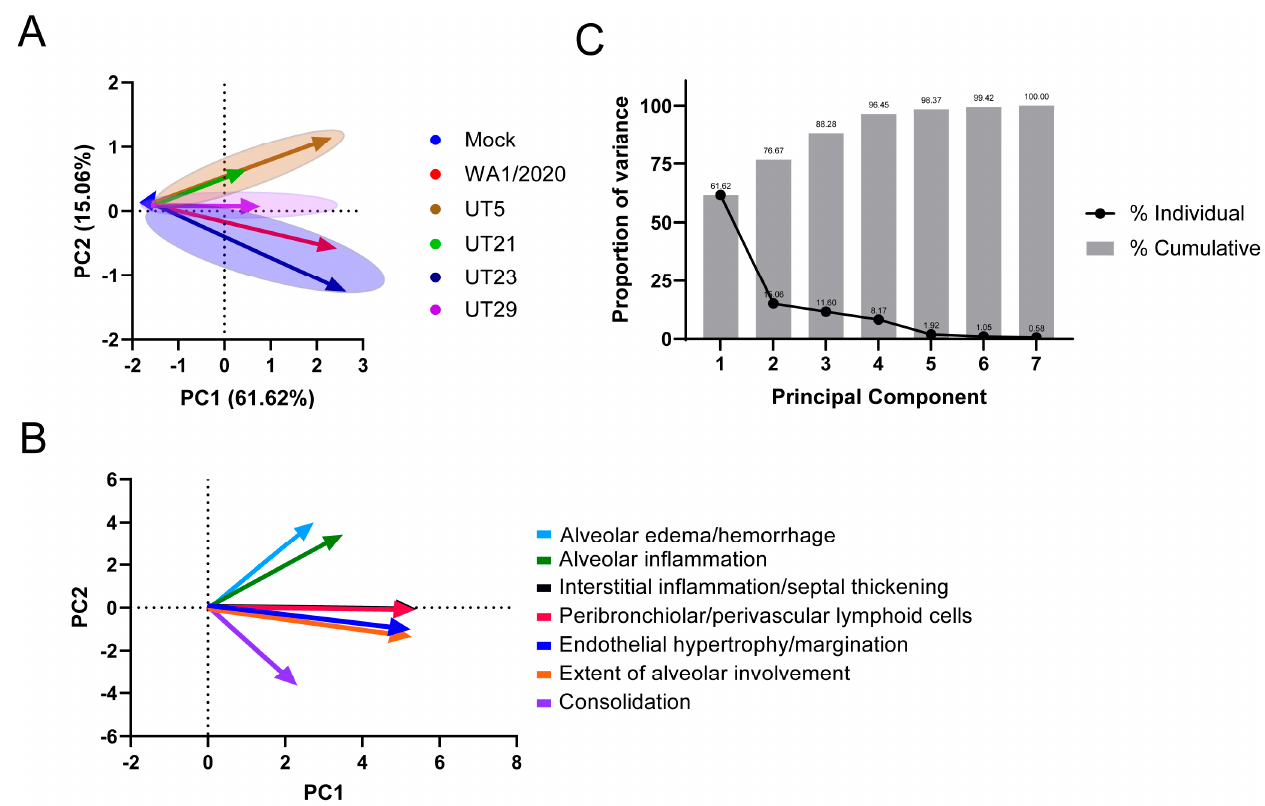
Figure 6. Principal component analysis of seven pathological features in lungs of K18-hACE2 mice infected with WA1/2020, UT5, UT21, UT23, or UT29. A principal component analysis (PCA) analysis of the pathology scores (Table S5) for mock, WA1/2020, UT5, UT21, UT23, and UT29 was conducted. Seven pathological features were scored (endothelial hypertrophy/margination, peribronchiolar/perivascular lymphoid cells, interstitial inflammation/septal thickening, alveolar inflammation, alveolar edema/hemorrhage, extent of alveolar involvement, and consolidation) for 1, 3, and 5 dpi. ( A ) The PCA plot distinguished the trend of each virus using 1 dpi (arrow tail) and 5 dpi (arrowhead) PC1 and PC2 values. ( B ) The PCA biplot is presented showing the association and trend of each parameter used for comparison, alveolar edema/hemorrhage (light blue), alveolar inflammation (green), interstitial inflammation/septal thickening (black), peribronchiolar/perivascular lymphoid cells (red), endothelial hypertrophy/margination (blue), the extent of alveolar involvement (orange), and consolidation (violet). ( C ) Proportion of variance from the principal component analysis of seven pathological features in lungs of K18-565 hACE2 mice infected with WA1/2020, UT5, UT21, UT23, or UT29. The line plot depicts the proportion of variance from each individual principal component (black dots), and the bar plot (grey bars) depicts the cumulative percentages of each of the principal components.